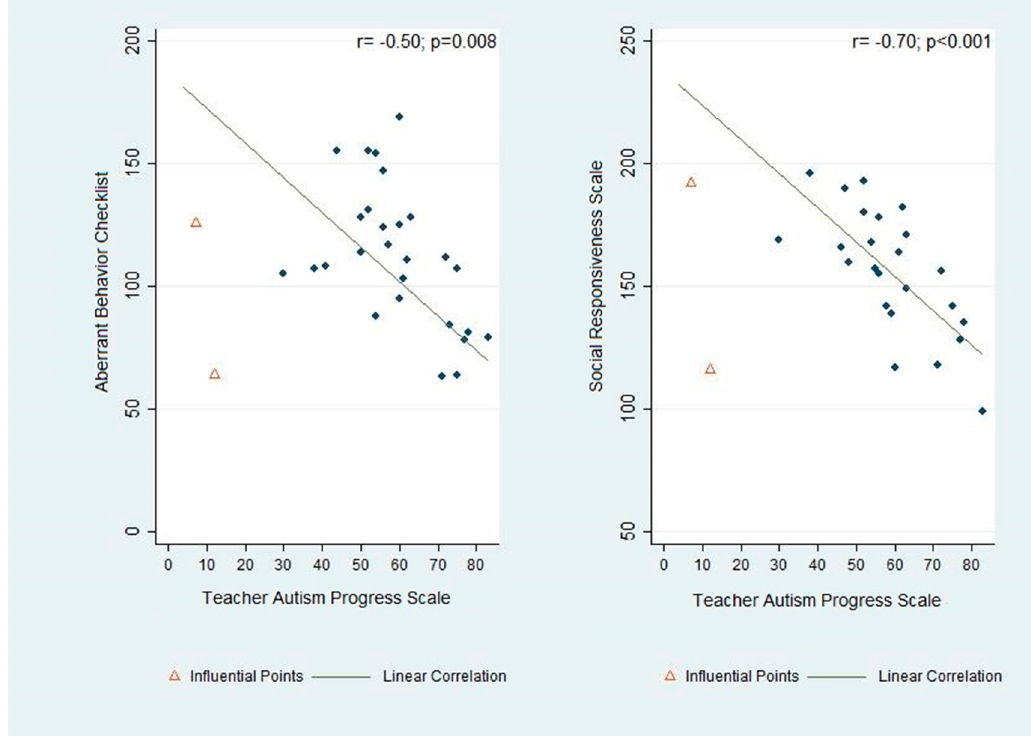
Figure 2. Analysis of the association between the progress of students at school and the outcome measures, aberrant behavior (left side) and social responsiveness (right side).